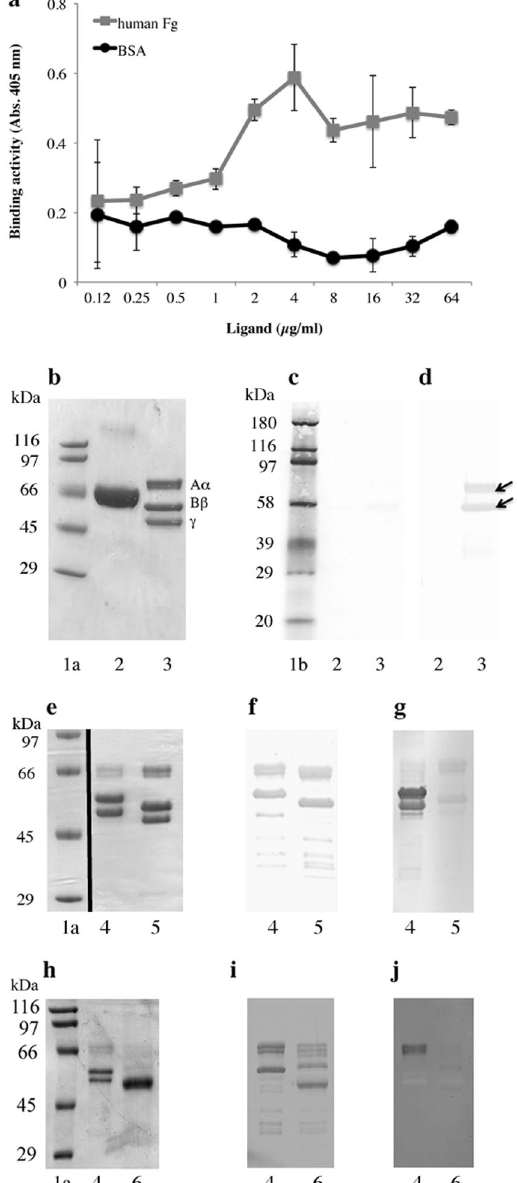
Figure 4. Binding of purified DsA1 to fibrinogen. ( a ) Various quantities of immobilized hFg were incubated with biotinylated DsA1 (0.1 μ g/ml). Bovine serum albumin (BSA) was used as a negative control. ( b ) Commassie blue staining of proteins (10 μ g per lane) separated by 10% SDS-PAGE. ( c ) HRP- streptavidin detection alone. ( d ) DsA1 binding (0.1 μ g/ml). Purified hFg was treated with ( e,f,g ) N-glycosidase F (PNGAse F) and ( h,i,j ) O-glycosidase. ( e,h ) Treated and untreated hFg (10 μ g per lane) were separated by 10% SDS-PAGE and detected by Coomassie blue staining. ( f,i ) Binding activity with biotinylated DsA1 (0.1 μ g/ml). Biotinylated ( g ) RCA-I and ( j ) jacalin lectins binding activities were used as a deglycosylation control, respectively. Lanes 1a and 1b correspond to unlabeled and biotinylated molecular weight standards, respectively. Lanes 2 and 3: BSA and hFg, respectively. Lanes 4 and 5: Untreated and enzymaticaly treated hFg,